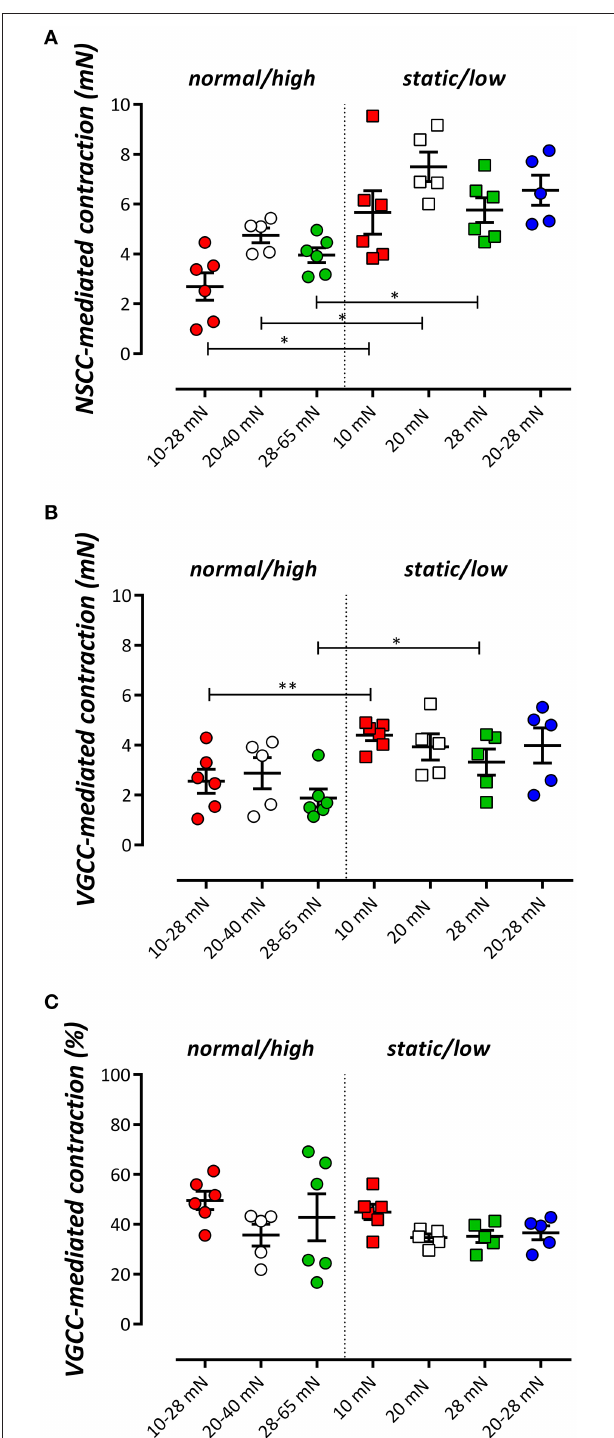
FIGURE 5 | The tonic contraction by 2 µ M PE mediated by NSCC Ca 2 + influx (A) or VGCC Ca 2 + influx (B) in the presence of 300 µ M L-NAME. VGCC were inhibited with 35 µ M diltiazem. The relative amount of VGCC-mediated contraction to the total contraction by PE is shown in (C) . * P < 0.01, ** P < 0.05 cyclic vs. corresponding static stretch. N = 5–6, one-way ANOVA with Tukey’s multiple comparison